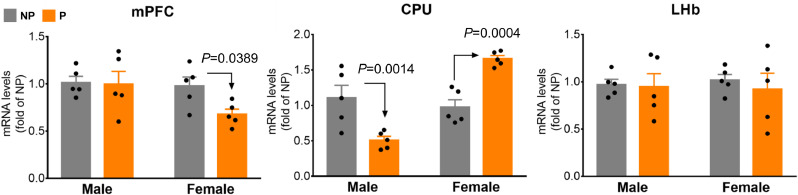
Sex- and brain region-dependant levels of Ppp1r12b mRNA in NP vs. P rats: left, mPFC; middle, CPU; right, LHb. The t-test-based exact P values of <0.05 only are showed in graphs; 3-way ANOVA implied significant model interaction with sex (P = 0.0161) (n = 5/group).